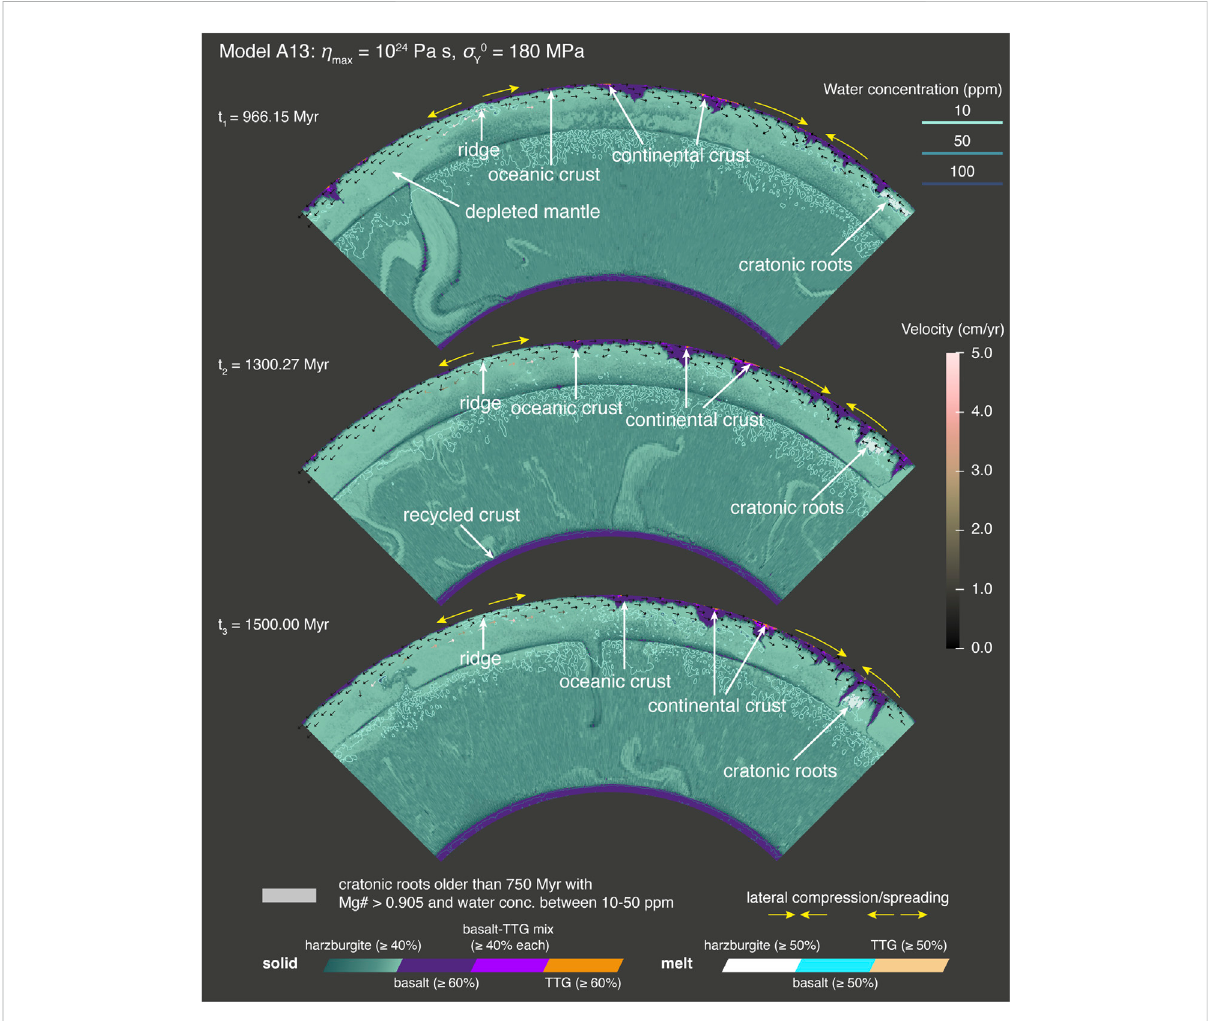
FIGURE 2 Compositional evolution with time of simulation A13 showing the formation of cratonic roots (grey shaded regions). The individual cells may contain more than one material at a given time, and therefore a threshold of minimum local concentration for each material is employed for their visualisation. Cell-based composition fi eld has the following solid and molten materials: TTG ( ≥ 60% in tangerine), basalt ( ≥ 60% in dark purple), harzburgite ( ≥ 40% in teal, lighter shades represent higher harzburgite content and mantle depletion), TTG-melt ( ≥ 50% in peach-orange), basaltic-melt ( ≥ 50% in sky blue), harzburgitic-melt ( ≥ 50% in white), and TTG-basalt-mix ( ≥ 40% TTG and ≥ 40% basalt in light purple). Superimposed are the contours for water concentration and velocity arrows in the